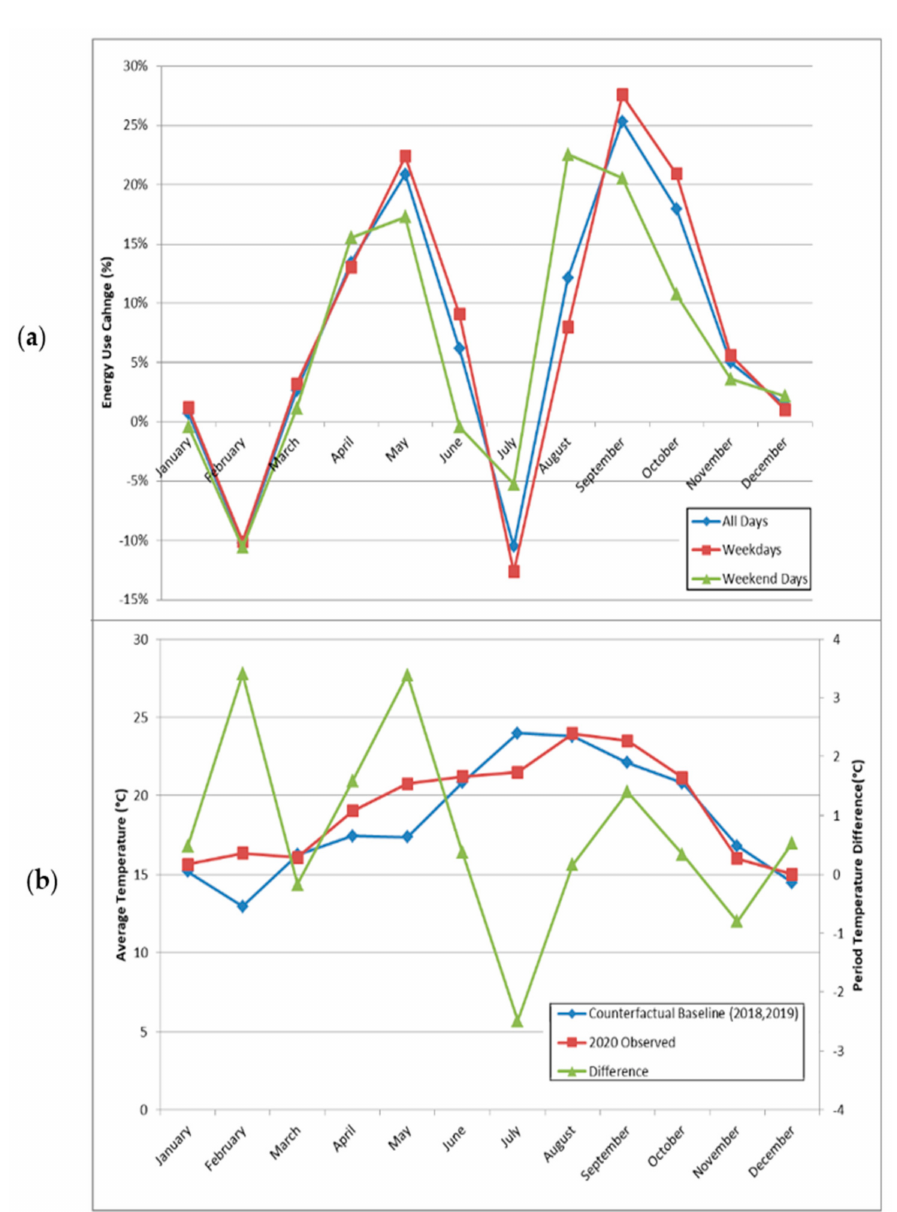
Figure 2. ( a ) Energy usage across all evaluated communities (simple composite average, not temper- ature normalized) with 2020 observation compared to a 2018–2019 comparison baseline, showing higher energy use. ( b ) Average monthly temperature as measured at weather data source KCQT in downtown Los Angeles observed for 2020 and comparison periods. Energy use strongly follows temperature change in relation to the mean static temperature